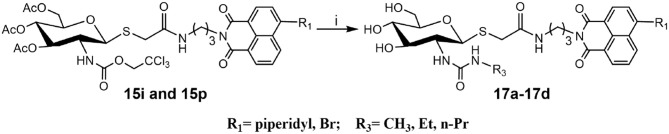
Synthesis of ureido glycosides 17a-17d. (i) R3NH2, MeOH. R1, and R3 are defined in Table 3.